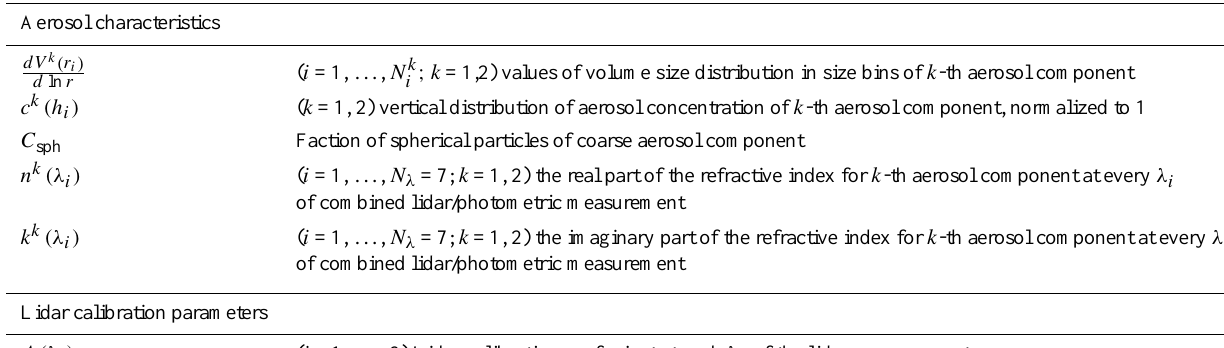
Table 1. Parameters retrieved by the algorithm. Aerosol